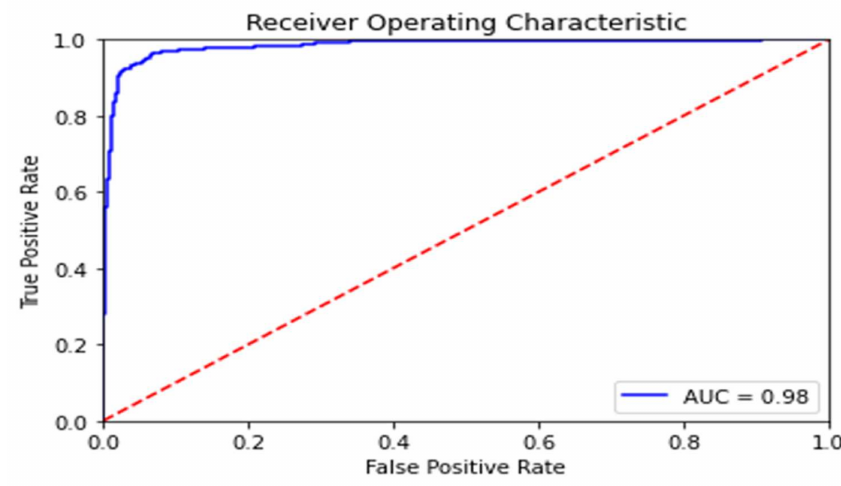
Figure 8. Receiver operating characteristic (ROC) with MobileNet algorithm. During the RT_LAMP-based experiment, gradual colour changes for positive samples were detectable with the naked eye in a 25 min to 30 min time gap depending on viral load. The corresponding samples were run on this prototype device with the inbuilt MobileNet model with a template matching algorithm, and temporal and real-time colour changes were monitored as described earlier. A clear colour change was detected and calibrated as early as 20 min on average and the RT-LAMP-based experiments are automatically stopped once the colour change is detected by the device, thus reducing the waiting time and power